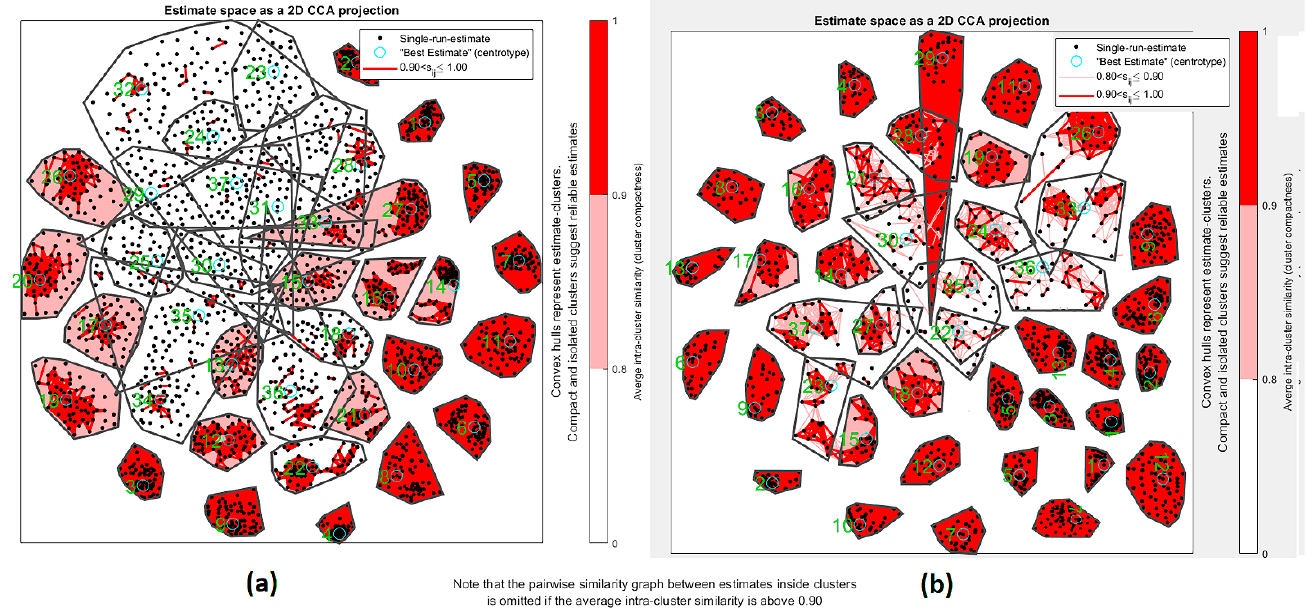
Figure 12. Estimated space as a 2D CCA projection for ICA repetition. Red color shown measure of correlation between clusters. ( a ) Measure of usual ICA based on bootstrapping dataset and repetition of ICA. ( b ) Proposed method of bootstrapping and repetition of ICA.